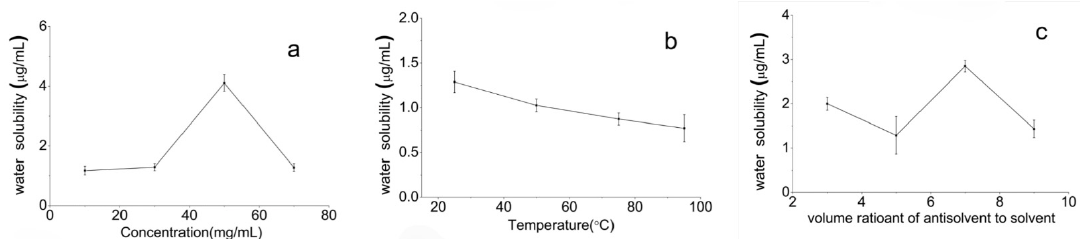
Figure 3. The effect of each parameter on the water saturation solubility of the PTX crystal powder. ( a ) Drug concentration; ( b ) temperature, and ( c ) volume ratio of antisolvent-to-solvent.